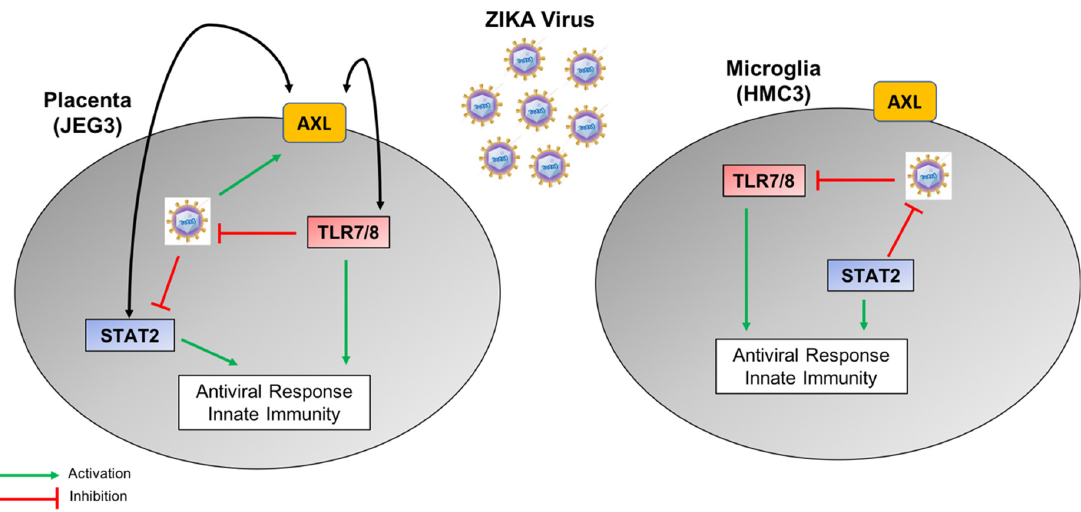
Figure 8. A potential schematic molecular model depicting the differing relationships between the expression of STAT2, TLR7, TLR8, and AXL during ZIKV infection in human placenta (JEG-3) and microglia (HMC3) cells.